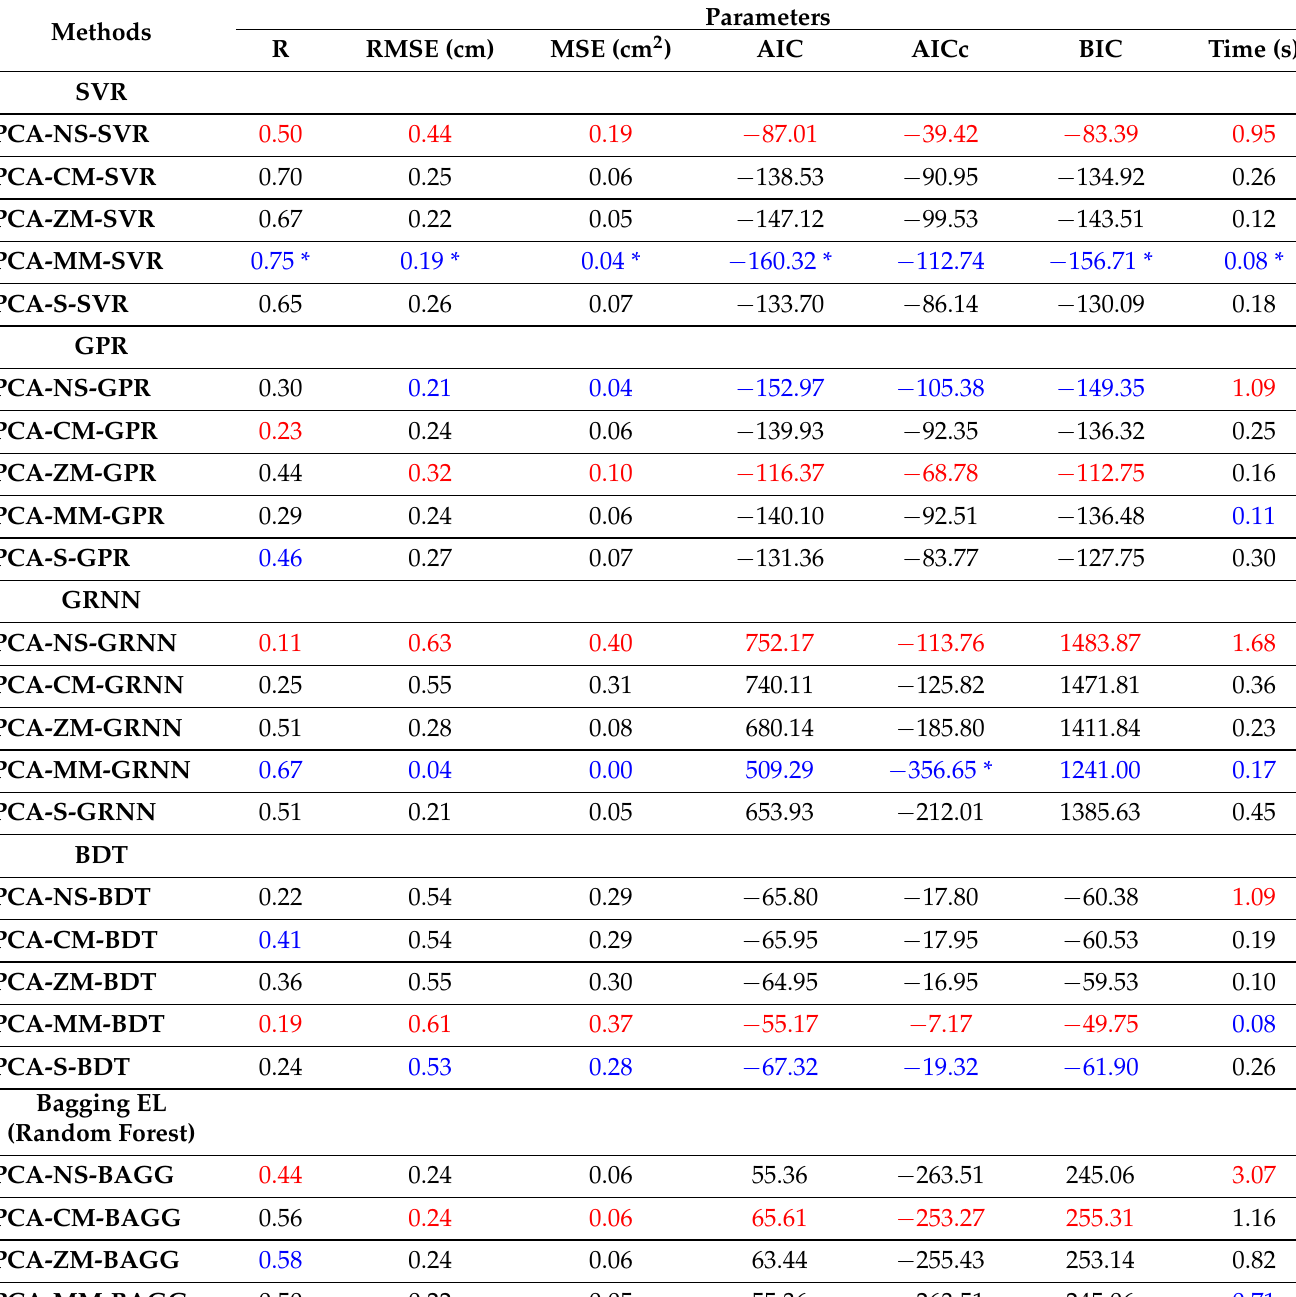
Table 4. Comparison of SVR model with the benchmark machine-learning algorithms.